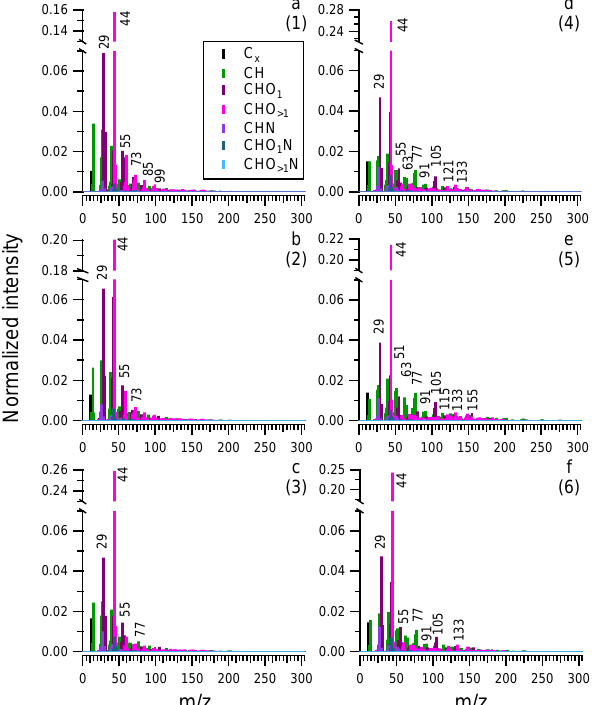
Figure 3. AMS high-resolution mass spectra for average-load ex- periments ( a–c , experiments 1–3) and high-load experiments ( d– f , experiments 4–6). Mass spectra from experiments 1, 2, 4 and 5 correspond to an OH exposure of 1.6 × 10 7 moleccm − 3 h. Experi- ments 3 and 6 correspond to 3h of aging. The legend in (a) applies to (a–f) .